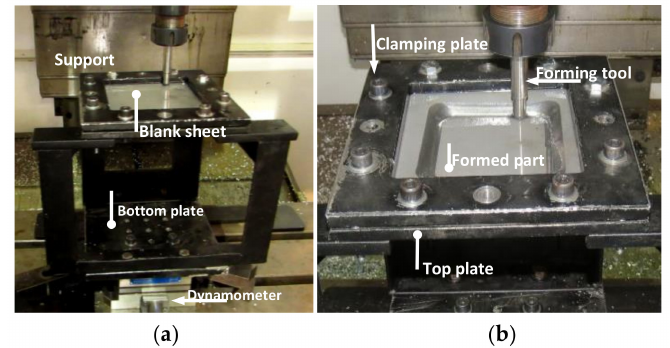
Figure 1. Single point incremental forming experimental setup mounted on a Kryle 9257 CNC milling machine: ( a ) SPIF fixture setup, and ( b ) forming tool with a hemi-spherical tip.